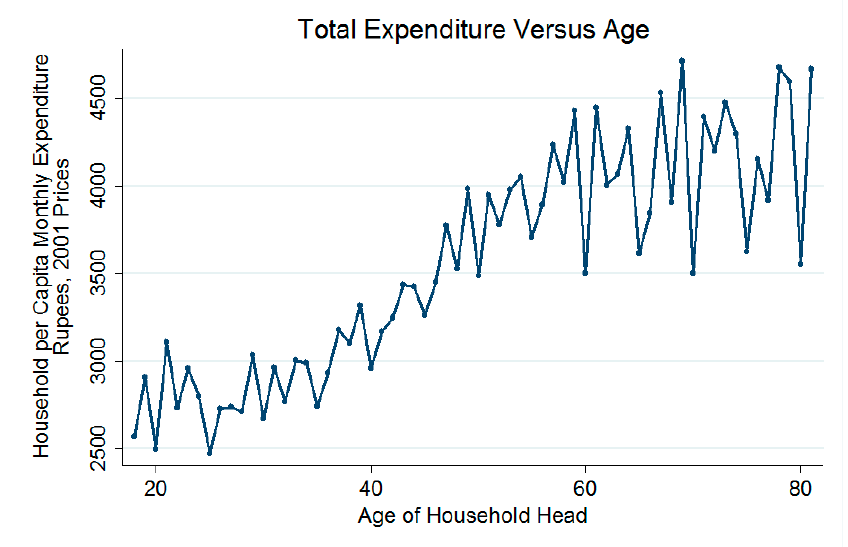
Figure 2. Age of Household Head.